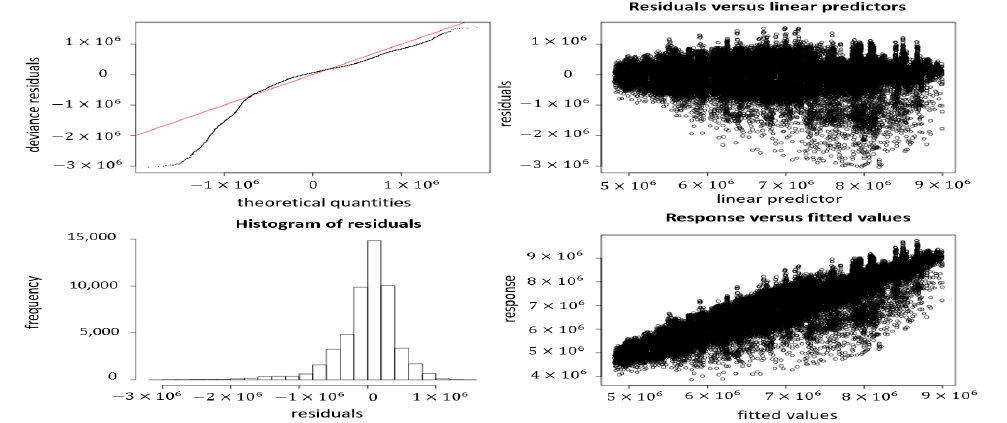
Figure 4. Diagnostic plot for non-spatial GAM.